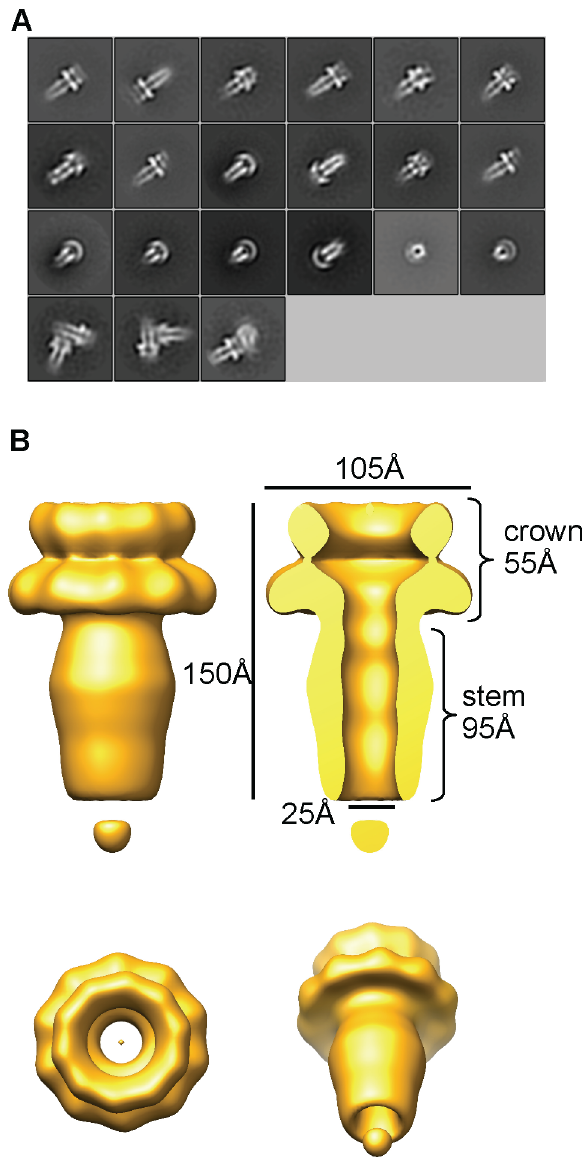
Fig 2. 3D reconstruction of the gp12 decameric assembly. (A) Class averages of the negatively stained gp12 decamer. The bottom row shows three class averages corresponding to stacked double decamers, demonstrating robustness of the 2D classification. The box size for class averages is 349.4 Å . (B) 3D reconstruction. Top left, front view. Top right, cutaway view. Bottom left, top view. Bottom right, tilted by 45° from the view on the